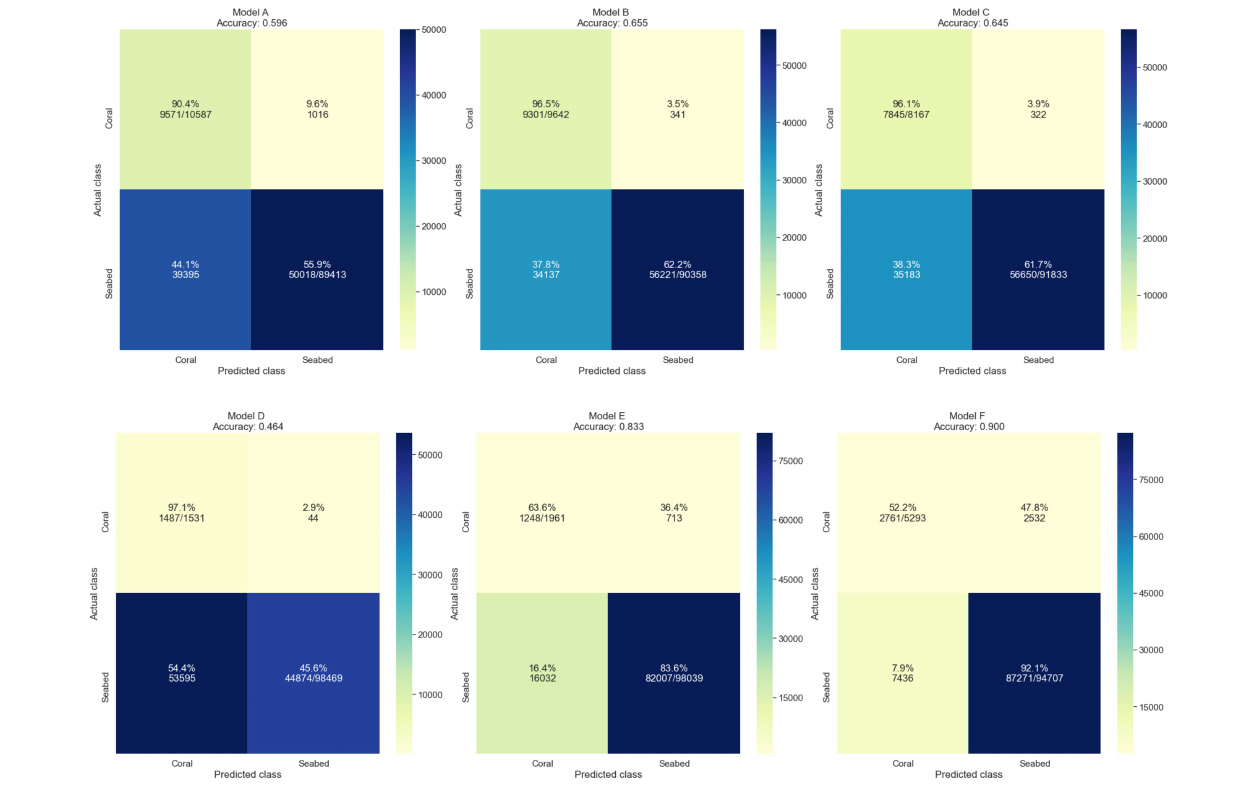
Frontiers in Marine Science |